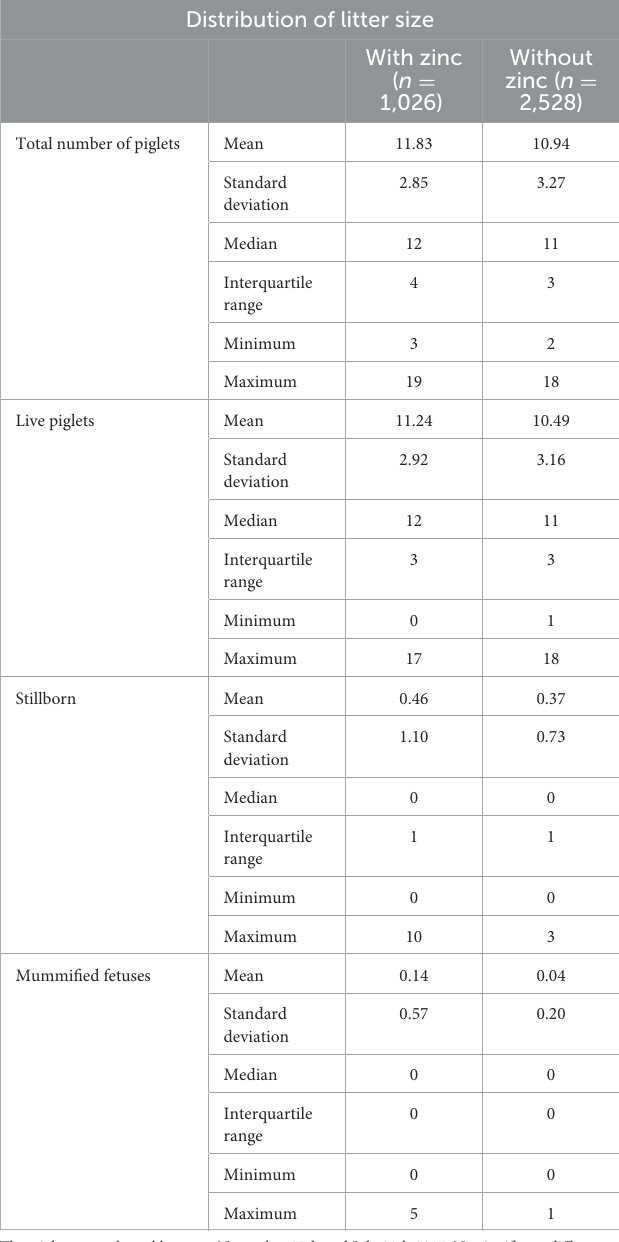
TABLE 5 Data collected from AI performed with sperm stored in the presence and absence of 2mM ZnCl 2 . Distribution of litter